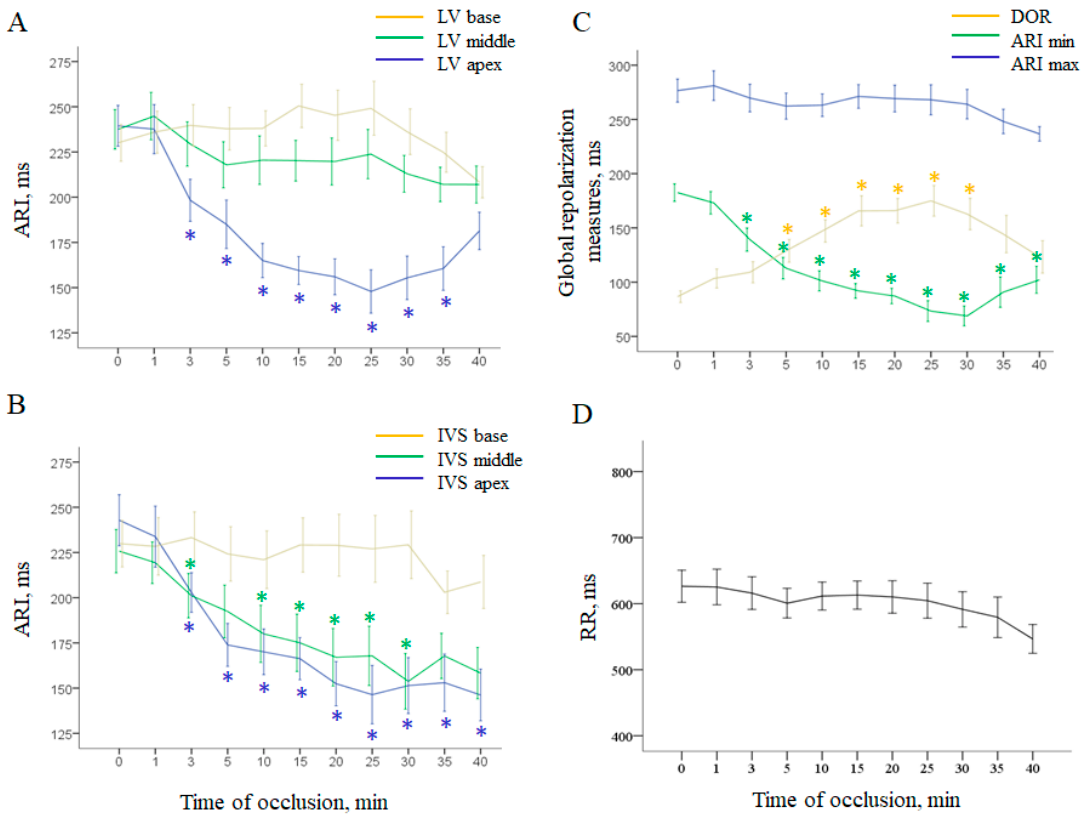
Figure 2. Ischemia-related changes of ventricular repolarization parameters (mean ± SEM). Panels ( A , B ) show local activation–repolarization intervals (ARI) in the left ventricular (LV) wall and interventricular septum (IVS), respectively. Panel ( C ) shows evolution of maximal and minimal ARIs throughout all intramyocardial leads and dispersion of repolarization (DOR). RR dynamics are presented in panel ( D ). * denotes statistically significant differences in respect to baseline (0 min). See distinct effects of coronary occlusion in the affected areas (LV and IVS apex and IVS middle part). Coronary occlusion also led to cardiac redox state modification. Compared with normal myocardium, all ischemic tissue samples were characterized by decreased levels of glutathione, total antioxidant capacity (TAC) and superoxide dismutase (SOD) activity (Figure 3).